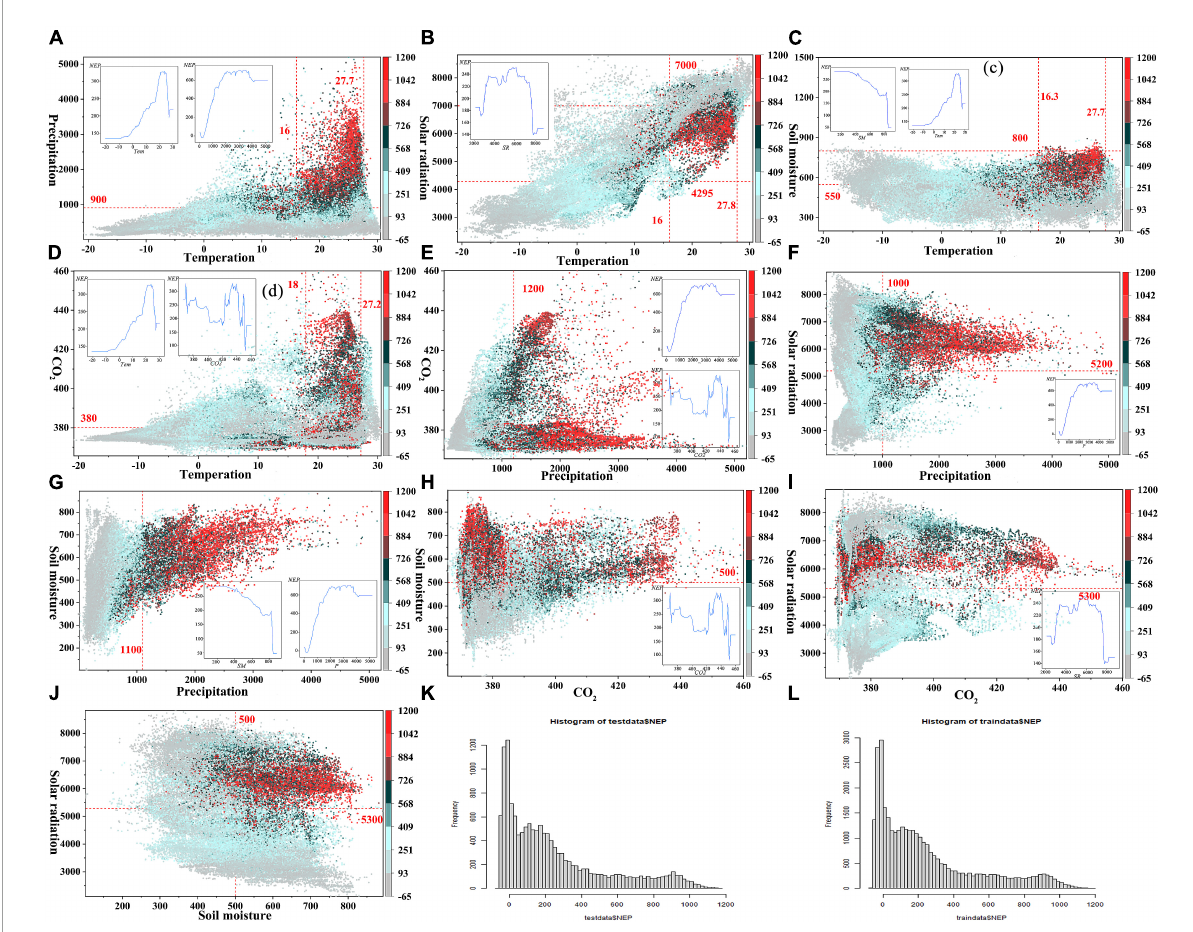
FIGURE4 The best contribution interval of each climatic factor to the NEP. Annual NEP in the climate domains based on the (A) T and P; (B) T and SR; (C) T and SM; (D) T and CO 2 ; (E) P and CO 2 ; (F) P and SR; (G) P and SM; (H) CO 2 and SM; (I) CO 2 and SR; (J) SM and SR; (K) NEP test data; and (L) NEP training